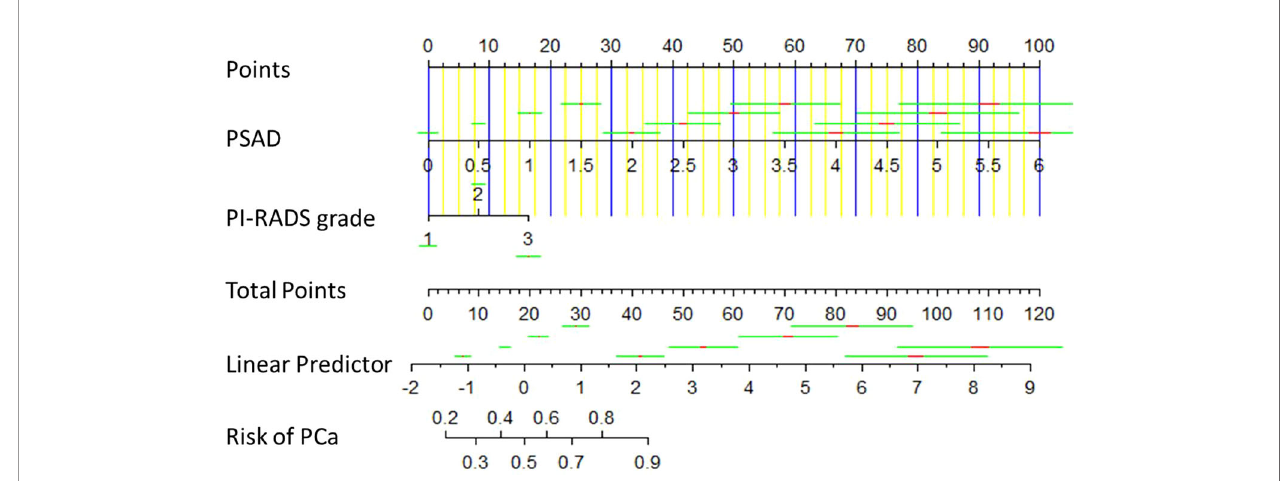
FIGURE 1 | Diagnostic nomogram for predicting the outcome of prostate biopsy. It was established by the development cohort. A total point was calculated by combining PSAD and PI-RADS grade, which parallels to a risk value of PCa.